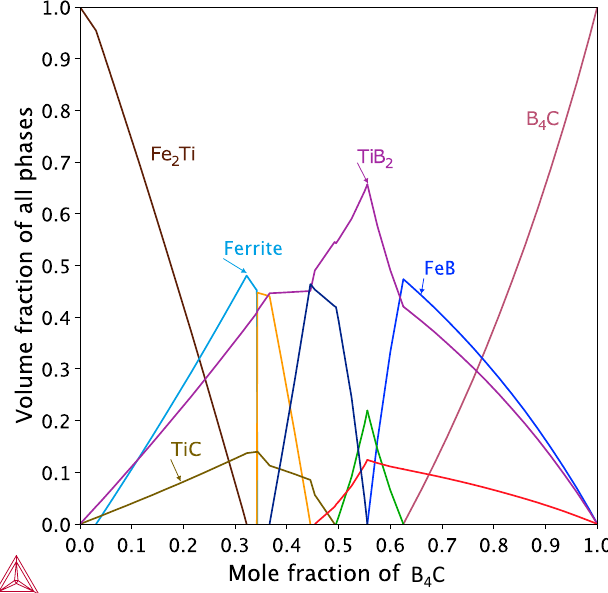
Figure 9. Fe 2 Ti—B 4 C property diagram simulated in Thermo-Calc ® for 1223 K.